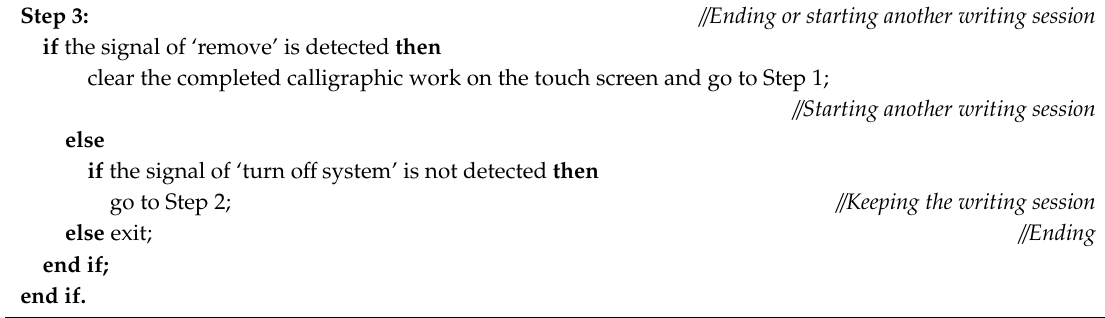
Table 4. List of intermediate interaction results of performing Algorithm 3.